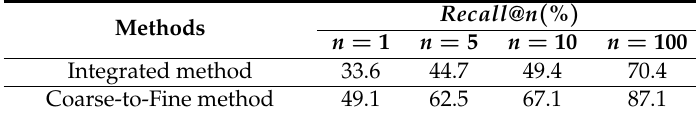
Table 4. Results of the conventional learning method trained on the Google Earth South Korea dataset